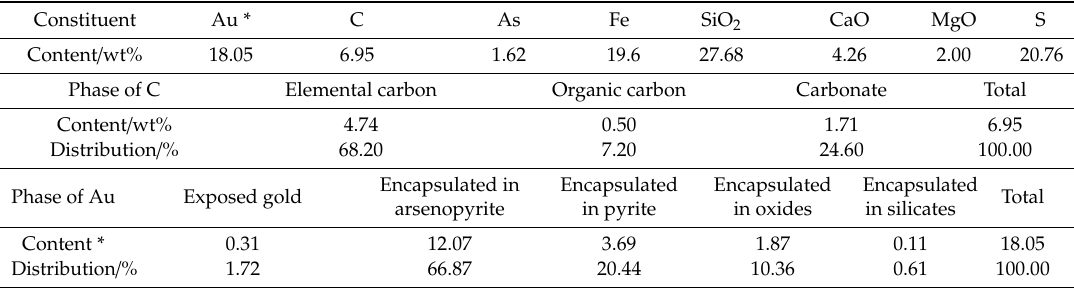
Table 1. Chemical composition and the phase constitution analysis of C and Au of the double refractory gold